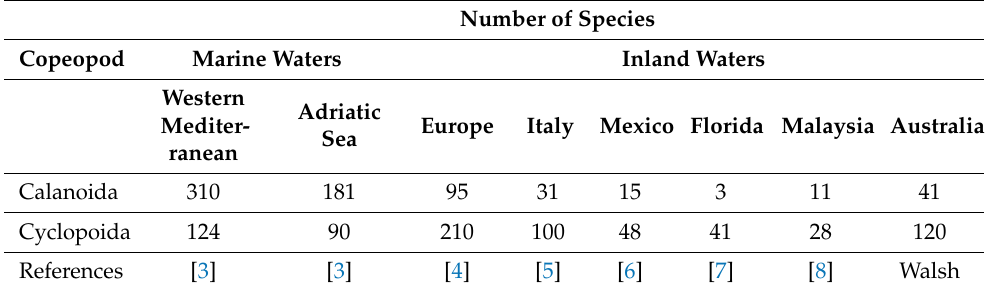
Table 1. Planktonic copepods. Some examples of species richness reported in marine and inland waters in areas of different geographic extension. (Data from references: [3–8]; and Walsh, per- sonal